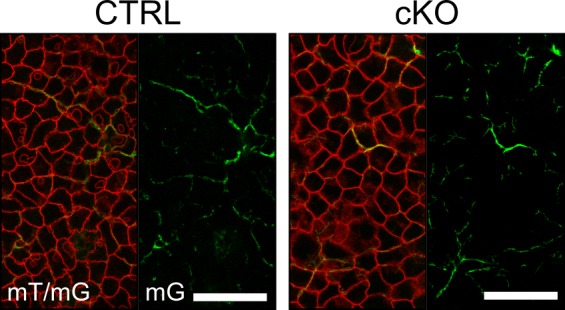
Innervation of the corneal epithelium.Representative maximum intensity projections of the epithelium in the center of the cornea of E18.5 embryos imaged on live tissues using the mT/mG reporter. Corneal epithelial cells are visualized with the tdTomato fluorescent reporter (mT) and the sensory nerves with the GFP fluorescent reporter (mG). Corneal epithelia of both genotypes are innervated. Scale bar, 50 μm.